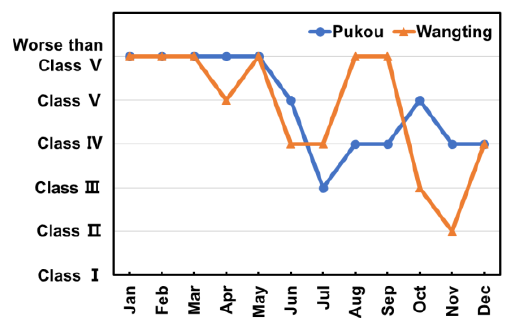
Figure 8. The monthly water quality classes for the two Baoding Municipal Ecology and Environment Bureau (BMEEB) monitoring stations in 2018.